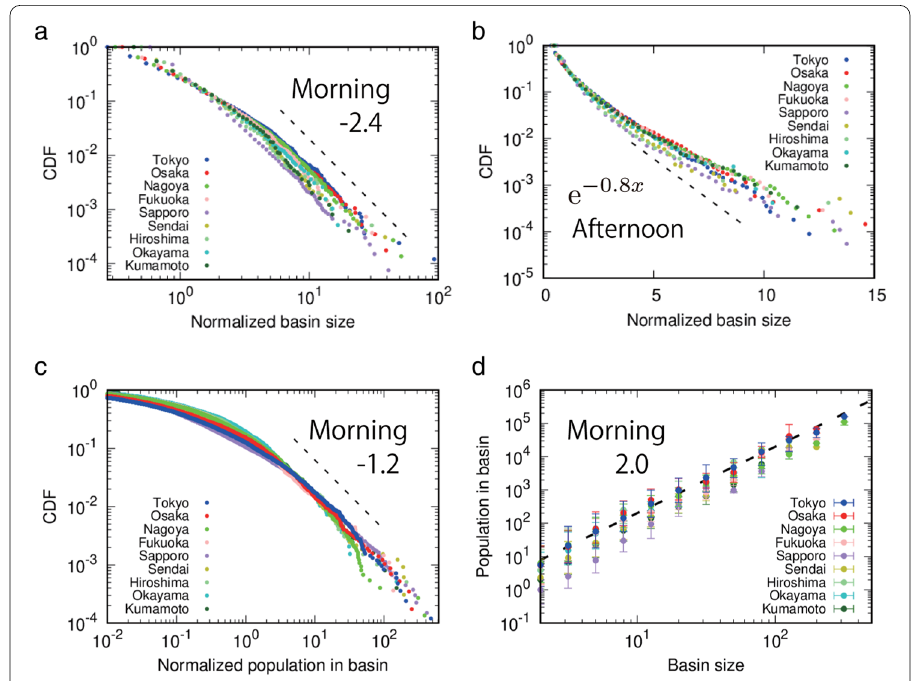
Fig. 8 CDF of basin size and population distributions for 9 cities in the year 2016. a , Morning and daytime basin size distribution in 9 cities (Tokyo, Osaka, Nagoya, Fukuoka, Sapporo, Sendai, Hiroshima, Okayama and Kumamoto), where the size definition is the number of combined squares. CDFs of the morning commuter rush hour are approximated with a power distribution of the exponent − 2.4 . b , The afternoon size distribution can be approximated by the exponential distribution (the dotted line). c , In the morning rush hours, CDFs of population of moving people in the basin follow a power distribution of exponents − 1.2 , where the population in the basin is normalized by the average population in basins. d , The number of people moving in the basin during the morning rush hours is proportional to the square of the size of the basin. Note , (All results are consistent with those shown in Ref. Shida et al. (2020) for the year